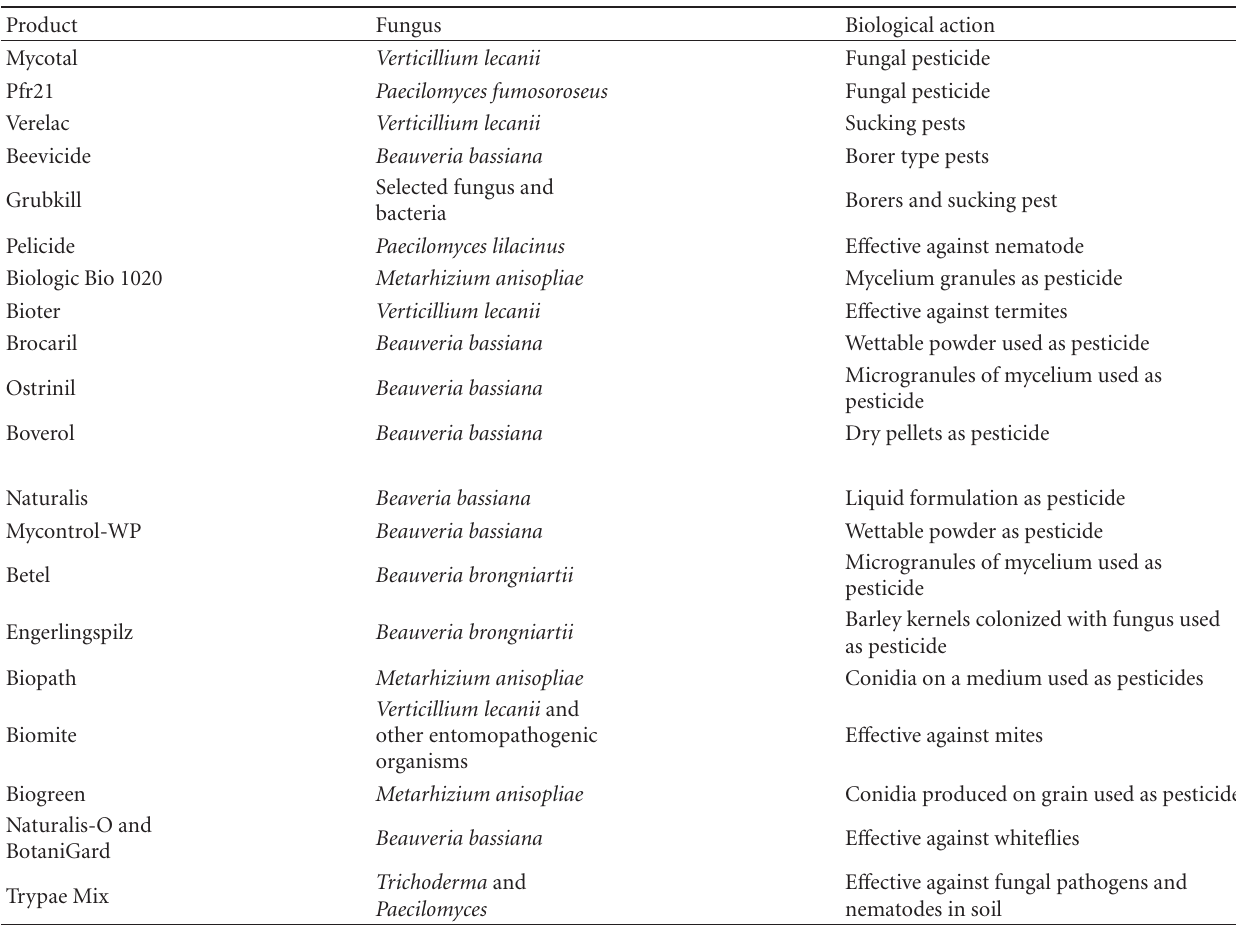
Table 2: Various bioactive products derived from entomopathogenic fungi which could be commercially useful for field application have been